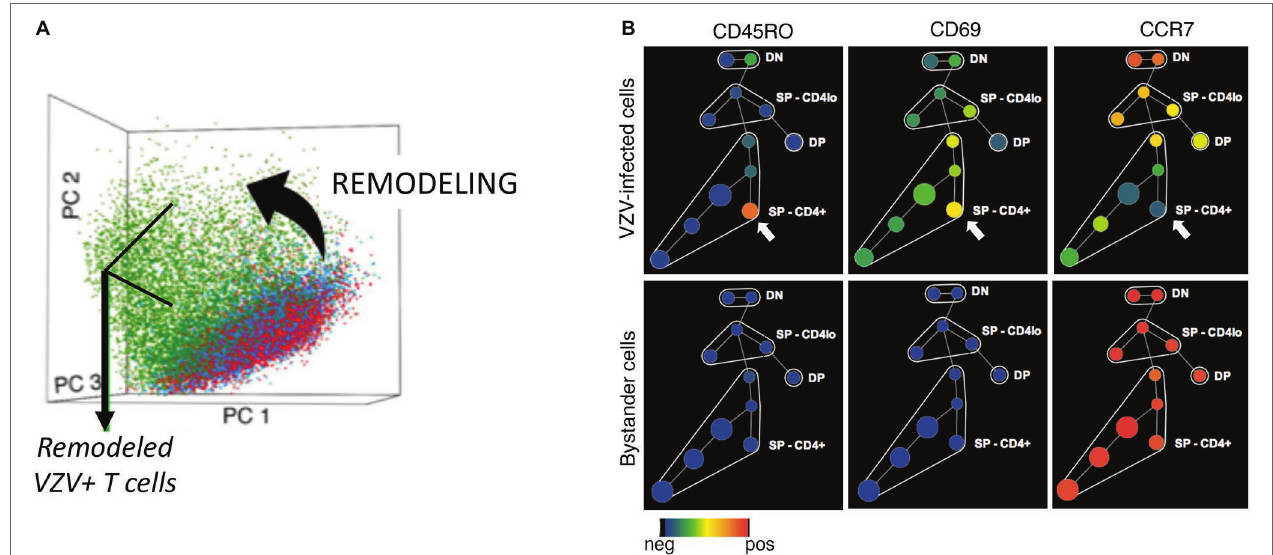
FIGURE 5 | Verification of the remodeling capacity of VZV infection demonstrated in naïve T cells. (A) PCA analysis of CD4 + naïve mock-infected, bystander, and VZV-infected T cells is shown as a scatterplot, where a dot represents a single cell. The mock-infected (red dots) and bystander (blue dots) cells occupied a single cell cloud based on CD4, CD8, CD45RO, and CD45RA expression. In contrast, the VZV-infected cells (green dots) had a unique distribution on the plot reflecting the “state transition” or remodeling of the naïve T cells to express phenotypes that marked them for skin trafficking. (B) SPADE analysis for visualization of the differential expression of surface proteins between VZV-infected and bystander cells. Adapted from Sen et al.